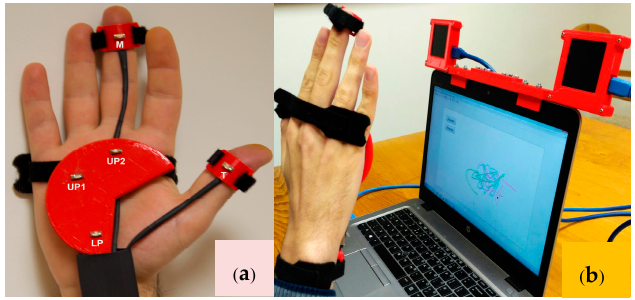
Figure 5. ( a ) Setup for hand; ( b ) final setup for hand tracking.